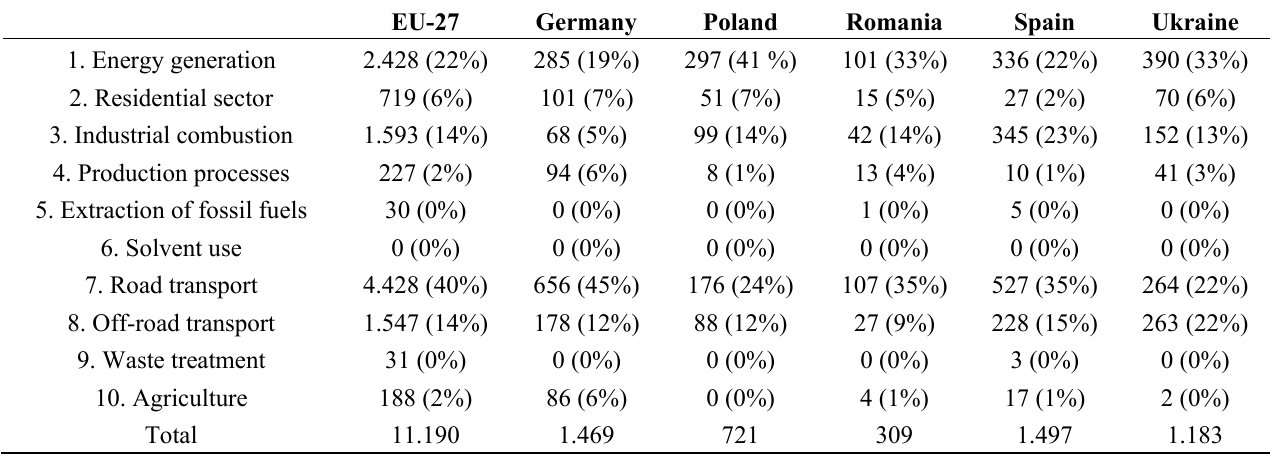
Table 1. Sector emissions (ktonnes) and contributions to national totals (%) for NO selected countries across Europe and the EU27 for